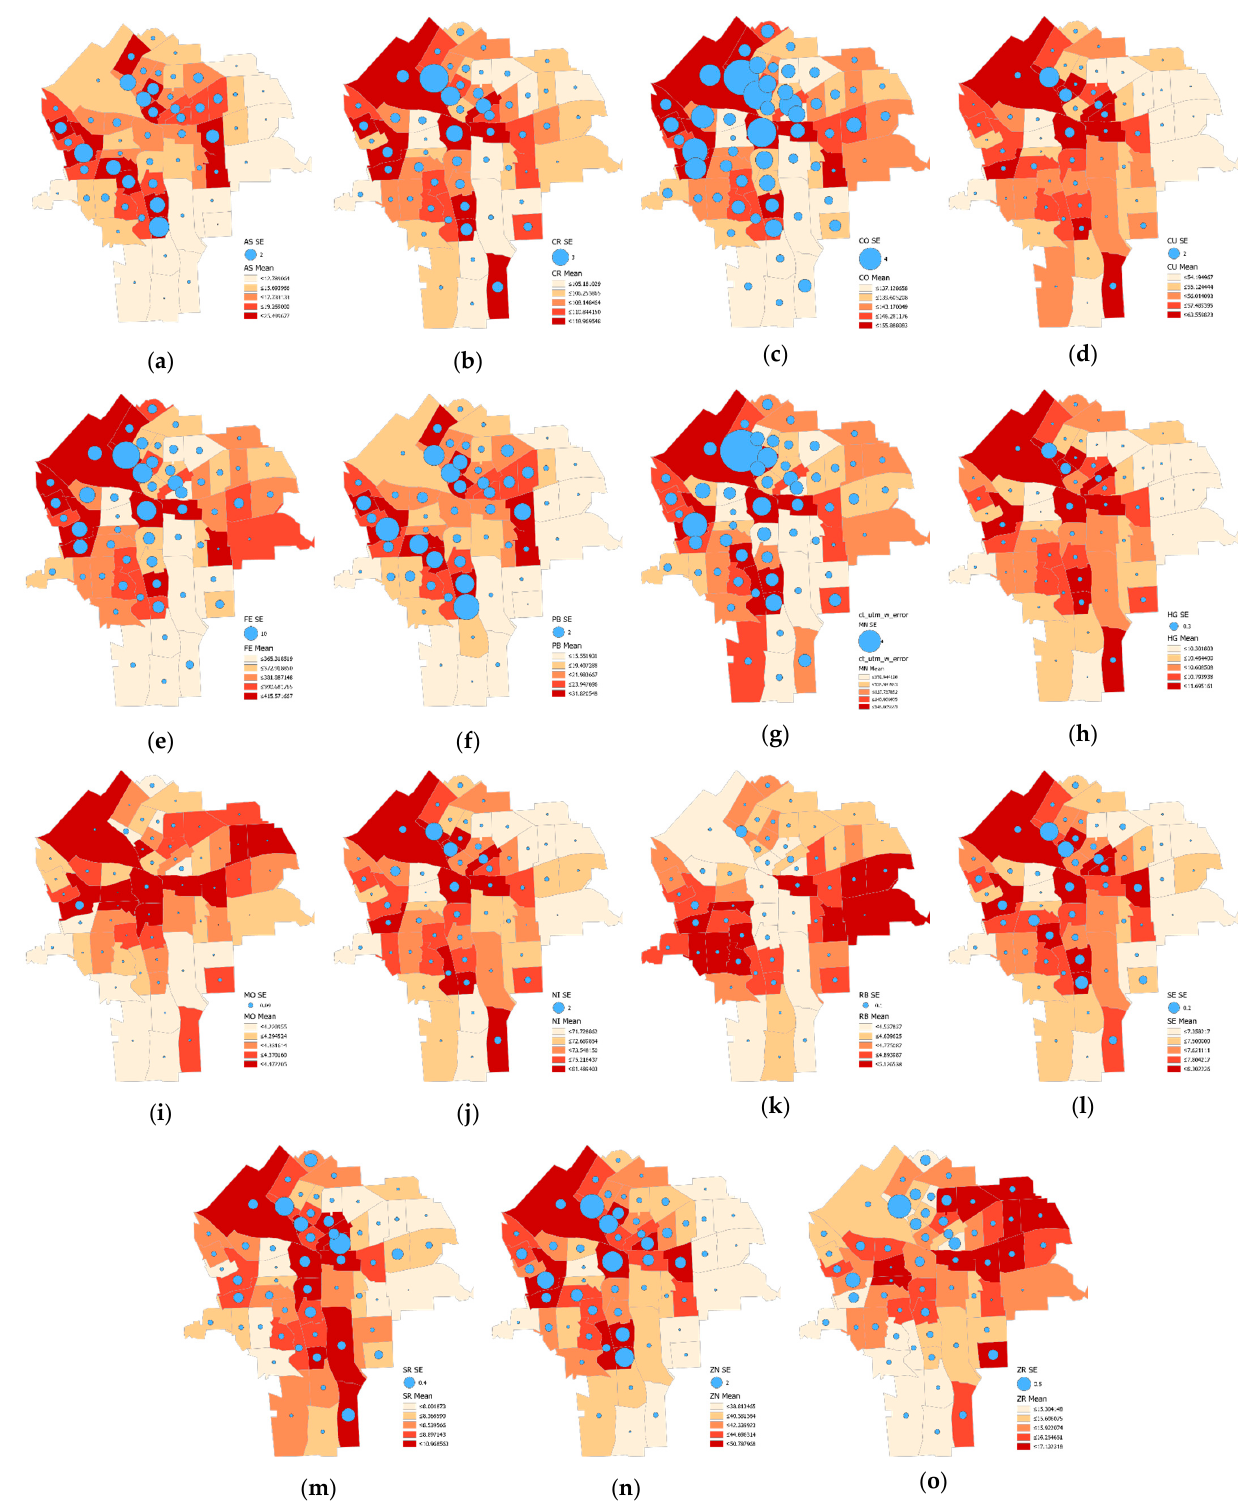
Figure 7. Choropleth maps with superimposed resampling error magnitude proportional circles portraying each of the 15 trace metals (census tract resolution): ( a ) As, ( b ) Cr, ( c ) Co, ( d ) Cu, ( e ) Fe, ( f ) Pb, ( g ) Mn, ( h ) Hg, ( i ) Mo, ( j ) Ni, ( k ) Rb, ( l ) Se, ( m ) Sr, ( n ) Zn, and ( o ) Zr.